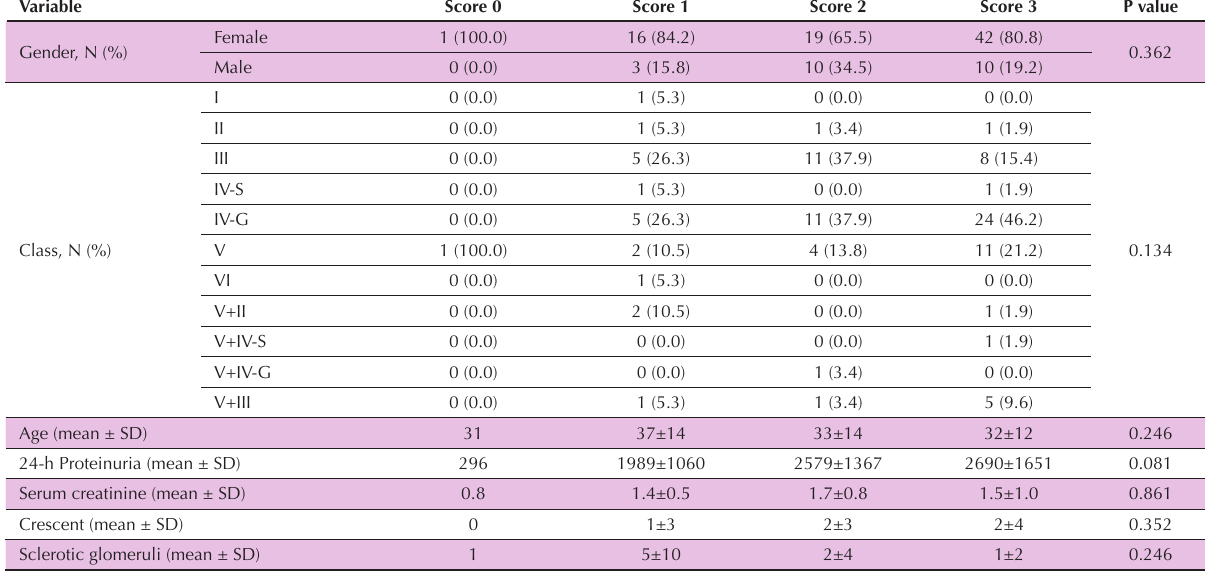
Table 4. Relationships between C3 grade score and the study variables